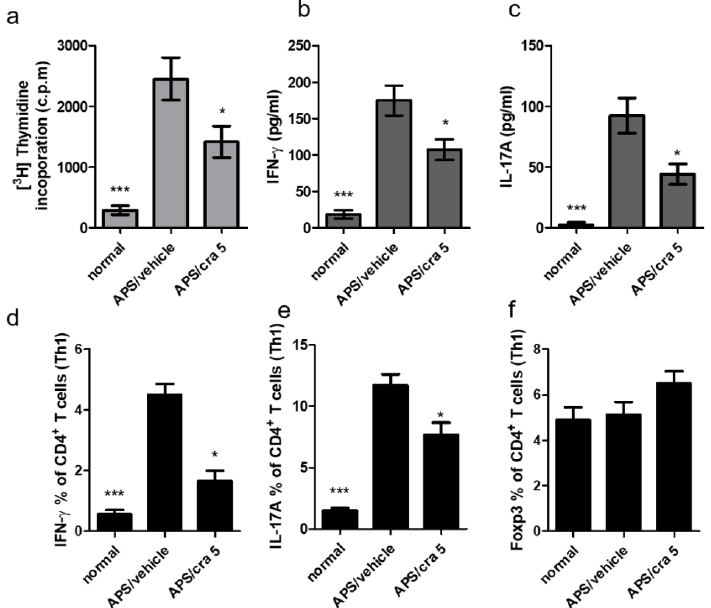
Figure 9. Effects of crassolide on cell proliferation and cytokines production in the spleen CD4+ T cells of APS mice after B2GPI stimulation. ( a ) Spleen was harvested on day 56 and cultured in the presence of B2GPI for 96 h. ( a ) Proliferation determined by radioactivity incorporation in count per minute (cpm) after pulsed treatment with 1 µ Ci of [ 3 H]thymidine per well for the last 18 h. ( b , c ) The amounts of ( b ) IFN-γ and ( c ) IL-17A in the culture supernatants measured by ELISA. ( d , e ) The percentages of ( d ) IFN-γ+, ( e ) IL-17A+ and ( f ) Foxp3+ cells among CD4+ T cells measured by flow cytometry. Data are presented as mean ± SEM of 5 mice from one of three independent experiments. * p < 0.05, *** p < 0.001, versus vehicle-treated APS mice group, tested by one-way ANOVA followed by Tukey’s multiple comparison test.